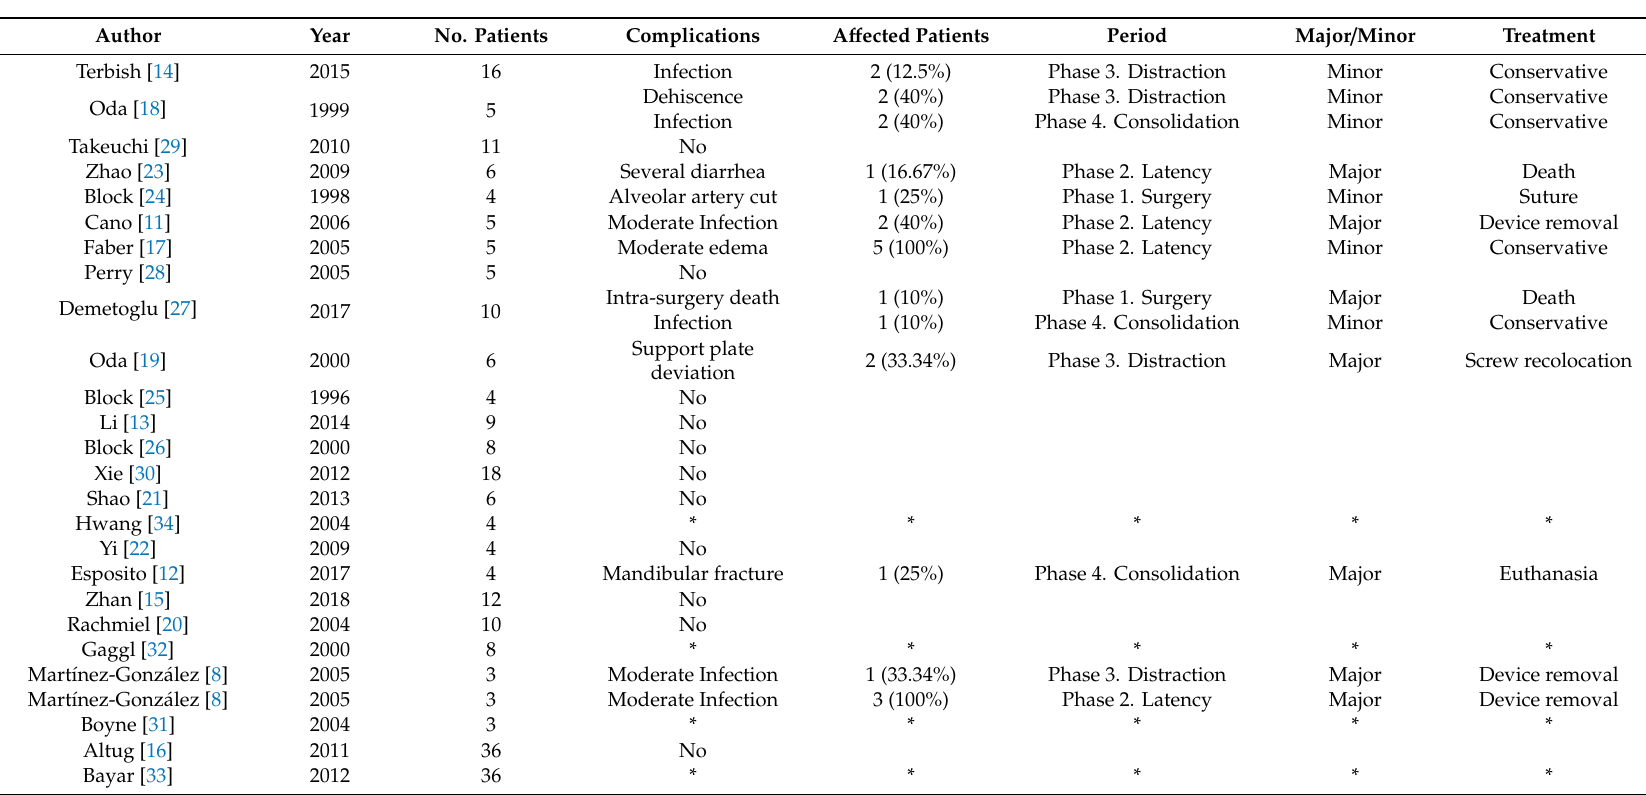
Table 4. Complications and treatments of the selected